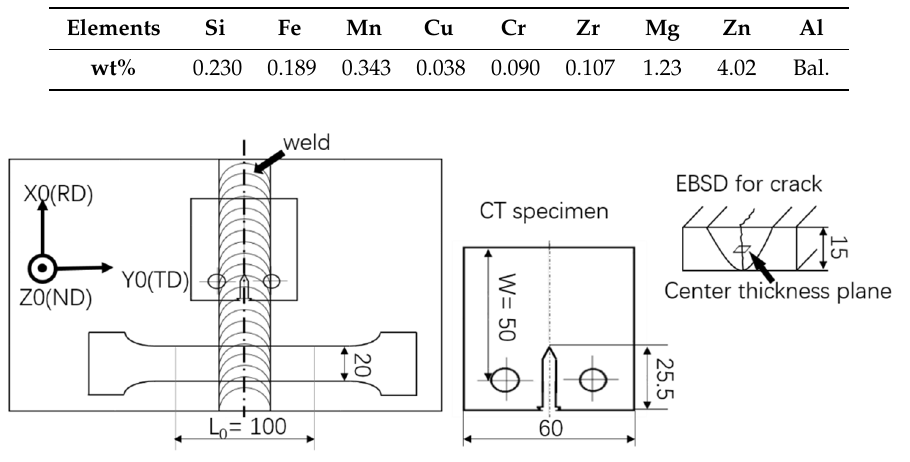
Figure 2. Schematic sample coordinate system; positions for CT (compact tension), tensile and EBSD specimens.